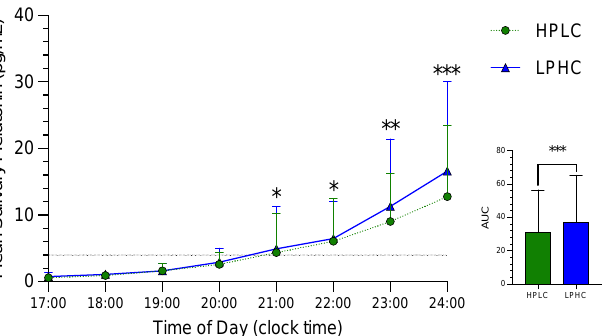
Figure 2. The time courses of salivary melatonin secretion and area under the curve (AUC) in HPLC vs. LPHC diets. HPLC: high-protein, low-carbohydrate; LPHC: low-protein, high carbohydrate. *: significant difference (HPLC vs. LPHC) with p < 0.05. **: significant difference (HPLC vs. LPHC) with p < 0.01. ***: significant difference (HPLC vs. LPHC) with p < 0.001.